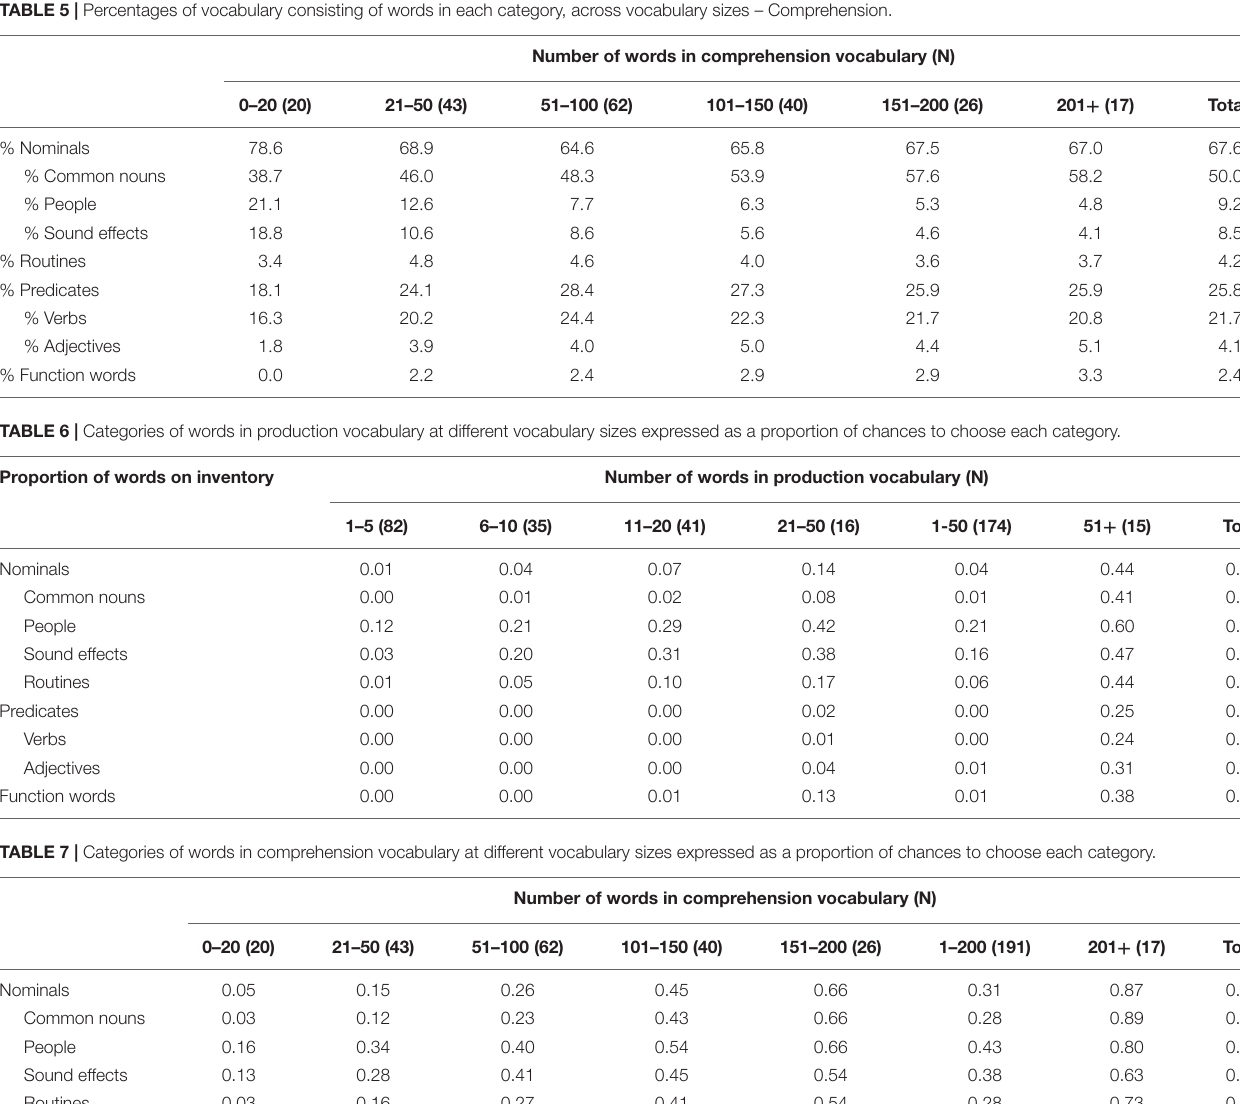
TABLE 5 | Percentages of vocabulary consisting of words in each category, across vocabulary sizes – Comprehension.